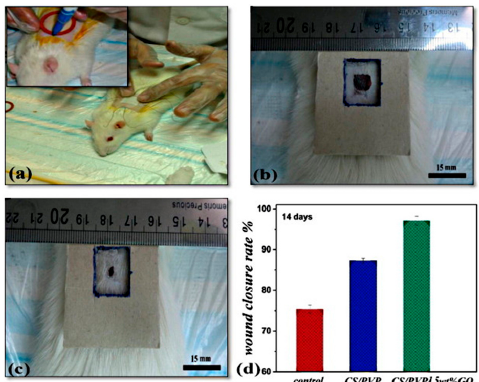
Figure 8. Electronic images show ( a ) surgery process of implantation of nanofibrous membranes on the open wound of a rat, and wound healing 14 days post-surgery for ( b ) pristine chitosan (CS)-based mat and ( c ) 1.5% GO-containing membrane. ( d ) Wound closure rate for the examined materials compared with the control (sterile gauze sponge). Reprinted from [152] with permission of Elsevier. Azarniya et al. integrated GO within chitosan (CS) and bacterial cellulose (BC), aiming at fabricating electrospun nanofibrous scaffolds for skin tissue engineering [153]. An enhancement in tensile strength and elastic modulus (40% and 115% increase, respectively) with about 60% decrease in elongation was measured for the 1.5% GO-reinforced nanocomposite as compared with the pristine CS/BC nanofibers. The addition of the GO nanosheets was accompanied with a gradual decrease of hydrophilicity. Furthermore, the presence of GO (1.5%) halved the water vapor permeability of the CS/BC nanofibers.